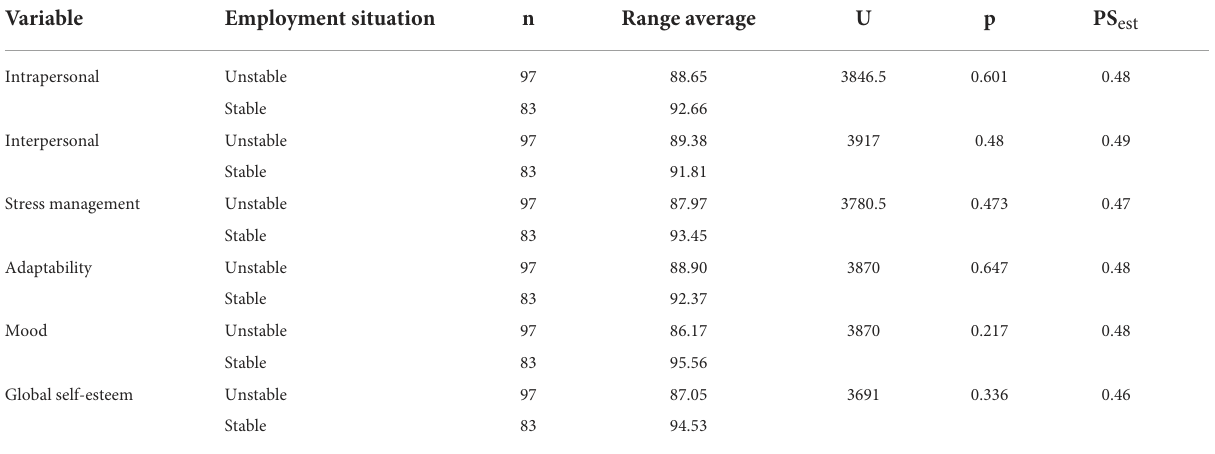
TABLE 4 Group comparison by employment